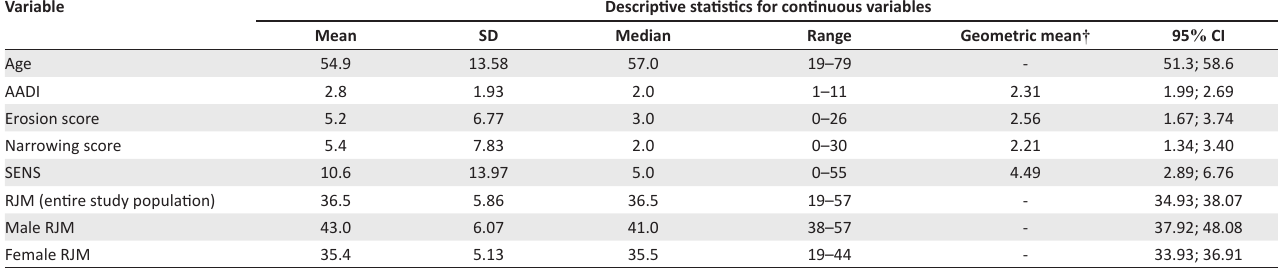
TABLE 1: Descriptive statistics for continuous variables.